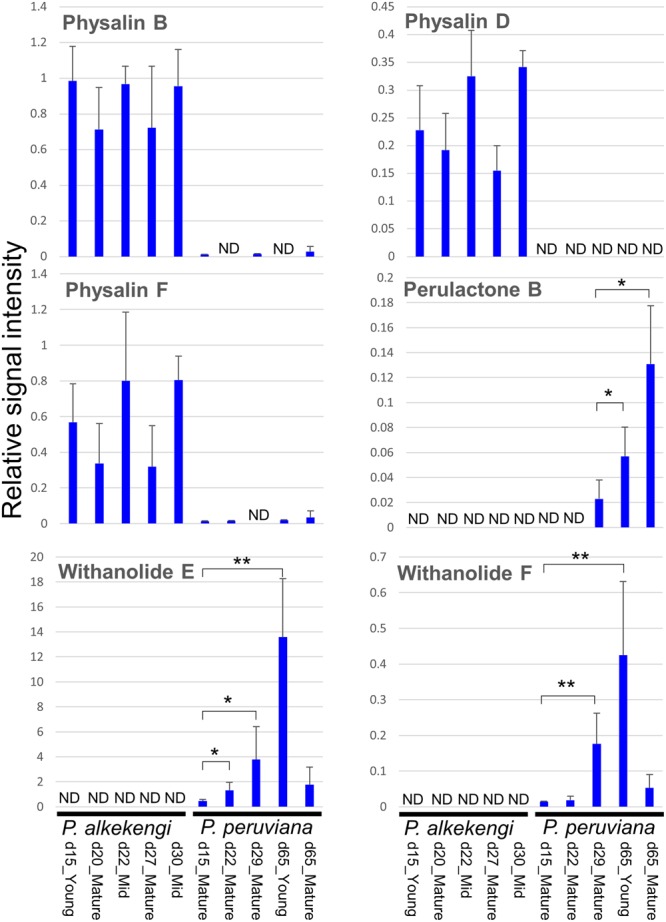
Measurement of six withanolides of the leaves from P. alkekengi and P. peruviana. Different developmental stages and leaf ages were used for comparison between P. alkekengi and P. peruviana. The analysis was performed with 3–6 biological replicates for each tissue/leaf age. An error bar indicates standard deviation. The authentic compounds used in this analysis were chemically synthesized as described in our previous paper (Ozawa et al., 2013). The limit of detection of each sample was 0.011923 (P. alkekengi, d15_Young), 0.010910 (P. alkekengi, d20_Mature), 0.013556 (P. alkekengi, d22_Mid), 0.010820 (P. alkekengi, d27_Mature), 0.010884 (P. alkekengi, d30_Mid), 0.012211 (P. peruviana, d15_Mature), 0.012456 (P. peruviana, d22_Mature), 0.012366 (P. peruviana, d29_Mature), 0.014794 (P. peruviana, d65_Young), and 0.013141 (P. peruviana, d65_Mature). Asterisks represent statistically significant differences from the sample of the youngest stage (i.e., d29_Mature for perulactone B and d15_Mature for withanolide E and F; t-test, ∗
p < 0.05 and ∗∗
p < 0.01). Abbreviation: d, day; Mid, middle; and ND, not detected.